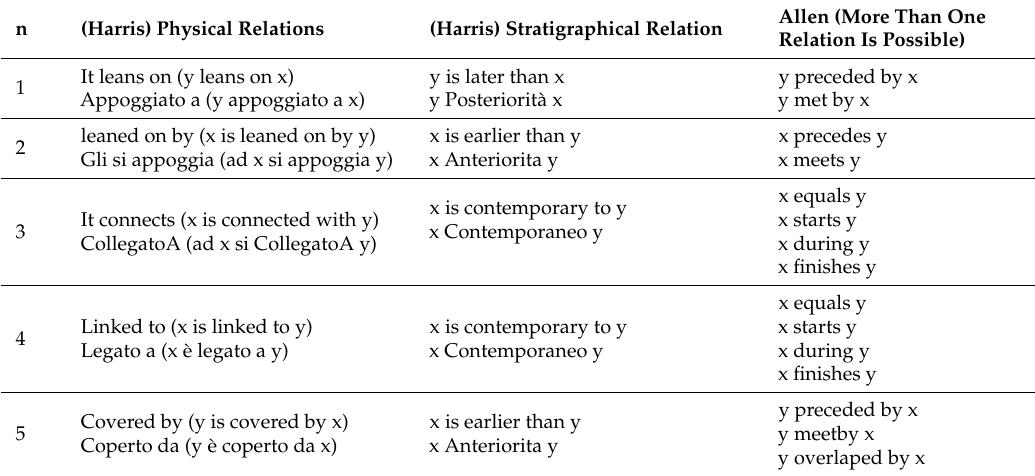
Table 3. From Harris to